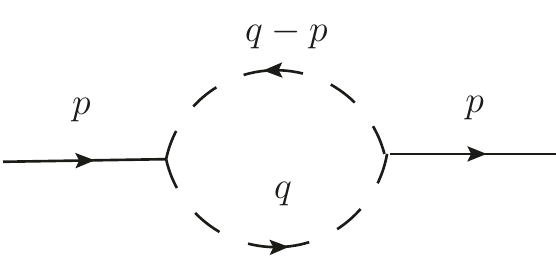
Figure 20. One of the three one loop corrections to the quadratic e(cid:11)ective action for (cid:27)